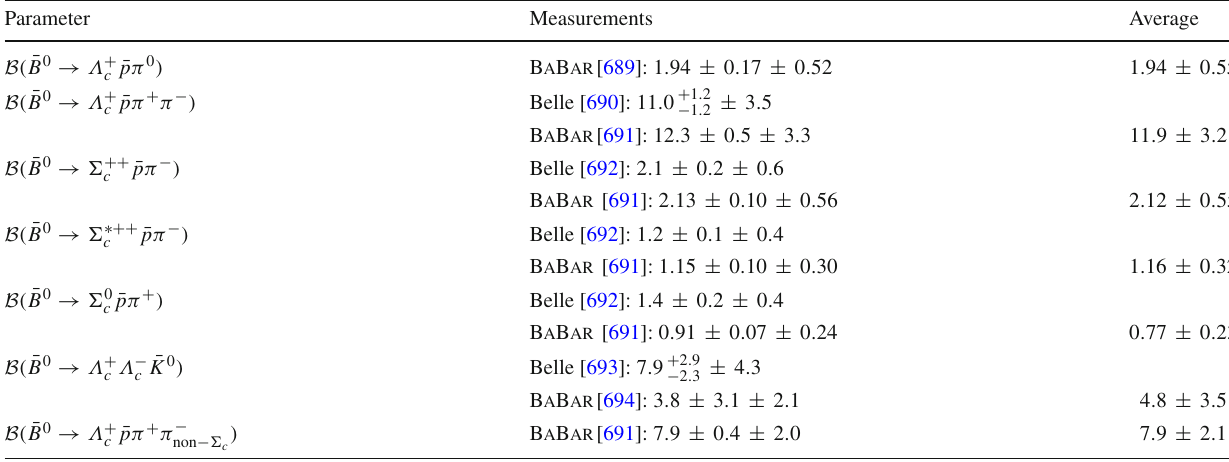
Table 125 Absolute decay rates to charm baryons I [ 10 − 4